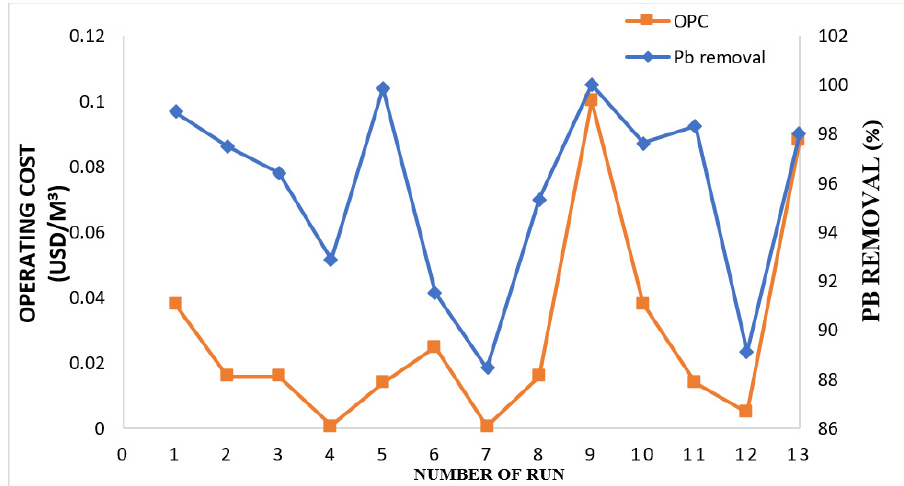
Figure 6. The operating cost vs. Pb removal through 13 experiments designed by CCD-RSM.